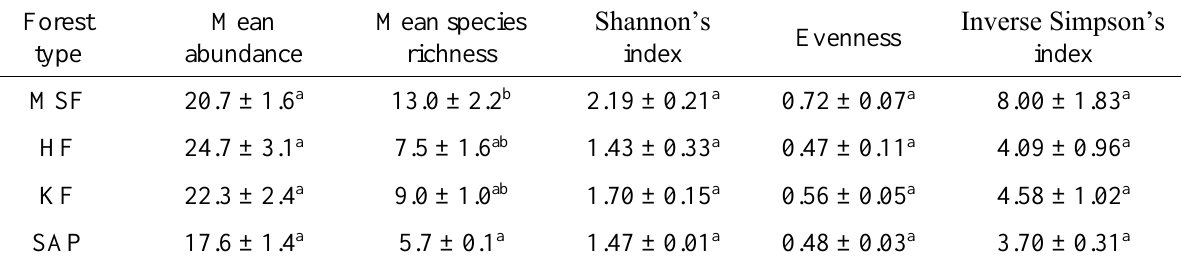
Table 2. Differences in mean seedling abundance and species richness, Shannon’s index, evenness, and inverse Simpson’s index of woody seedlings (50 ≤ height (cm) ≤ 100) in four different forest types: mixed peat-swamp forest (MSF, n = 4 plots), heath forest (HF, n = 6 plots), kerapah forest (KF, n = 6 plots) and Shorea albida peat-swamp forest (SAP, n = 6 plots). Values are mean ± SE, calculated over the total number of plots per forest type. Same letters within a column represent no significant differences between forest types and different letters represent significant difference at α = 0.05 as analysed using one-way ANOVA and Tukey’s HSD